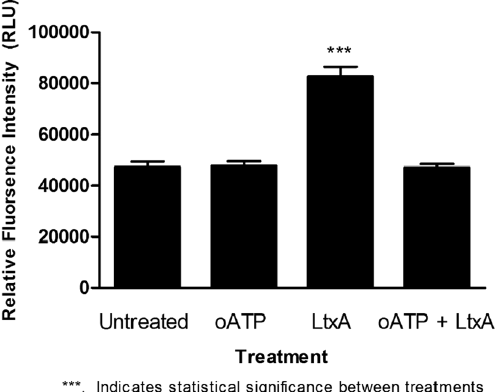
Figure 11. Intracellular Ca 2+ mobilization of LtxA treated Jurkat cells. Jurkat cells were treated with LtxA alone or pre-treated with oATP following LtxA treatment and assessed for intracellular Ca 2+ mobilization using a fluorescent based assay. Preventing the binding of ATP to P2X 7 R using oATP reduced intracellular Ca 2+ mobilization to that of untreated cell control levels. Where indicated, cells were pretreated with oATP at a concentration of 600 µM for 1 h prior to LtxA treatment. LtxA was used at a concentration of 0.3 µg/mL for 30 min. ***p <